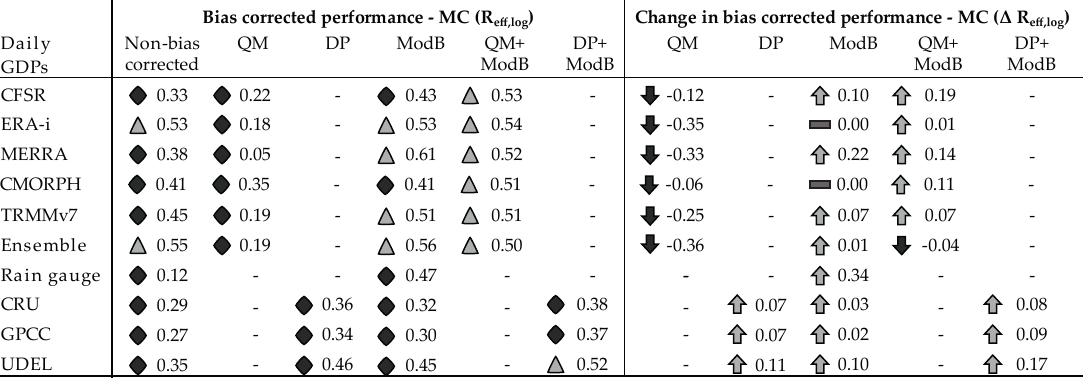
Table 4. Performance scores for MC discharge simulations. Performance is shown as R eff , log values for each bias correction technique